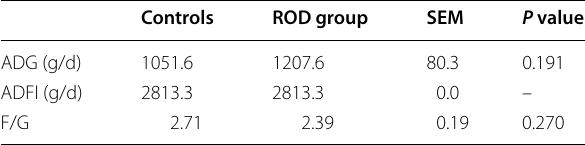
Table 2 Effects of ROD polyphenol extract supplementation